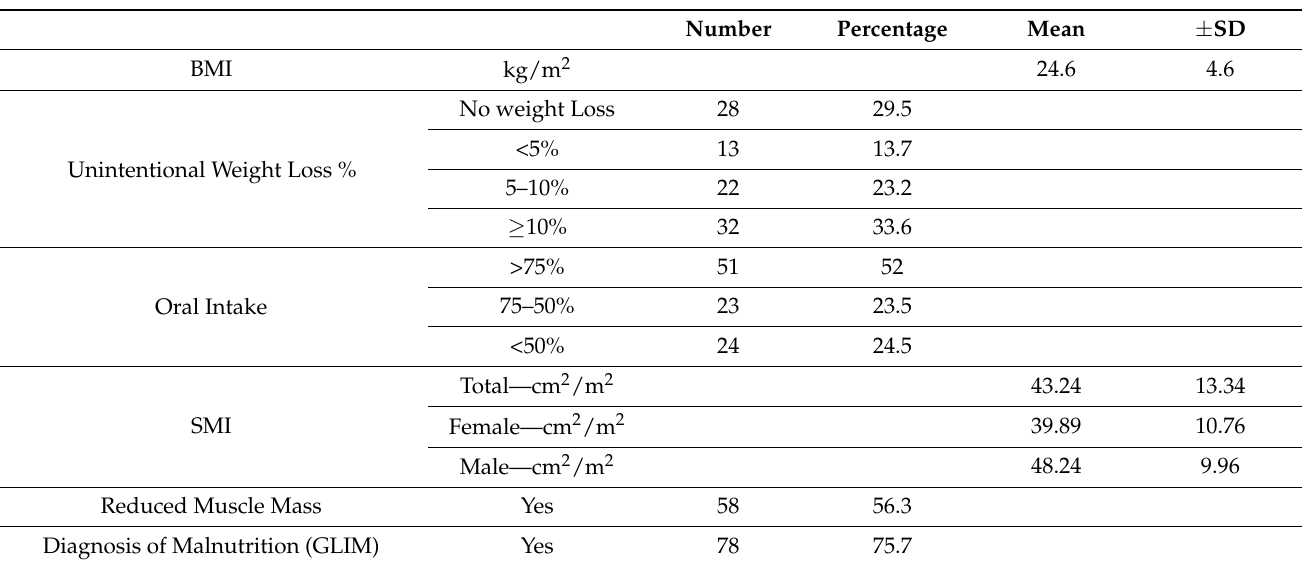
Table 2. Nutritional parameters before